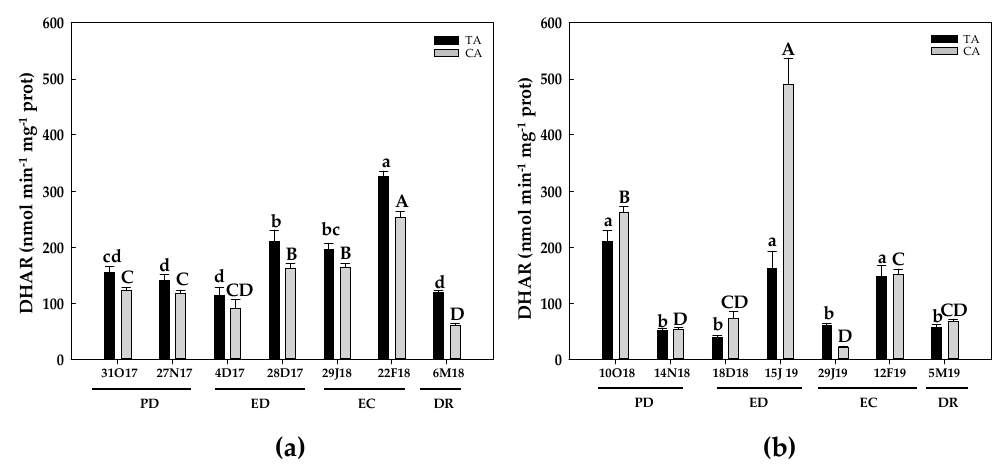
Figure 9. Evolution of dehydroascorbate reductase (DHAR) activity in flower buds of peach ‘GEM020’ cultivated in two different geographical areas during the dormancy cycle on two seasons. ( a ): season 1 (2017–2018); ( b ): season 2 (2018–2019). Data represent the mean ± SE, n = 5. Different letters (lowercase and uppercase for the samples of the temperate (TA) and the cold area (CA), respectively) indicate significant differences according to Tukey’s multiple test ( p ≤ 0.05). PD: paradormancy; ED: endodormancy; EC: ecodormancy; DR: dormancy release. FW: fresh weight. The chill units accumulated at the different times and locations are shown in Supplemental file 1.